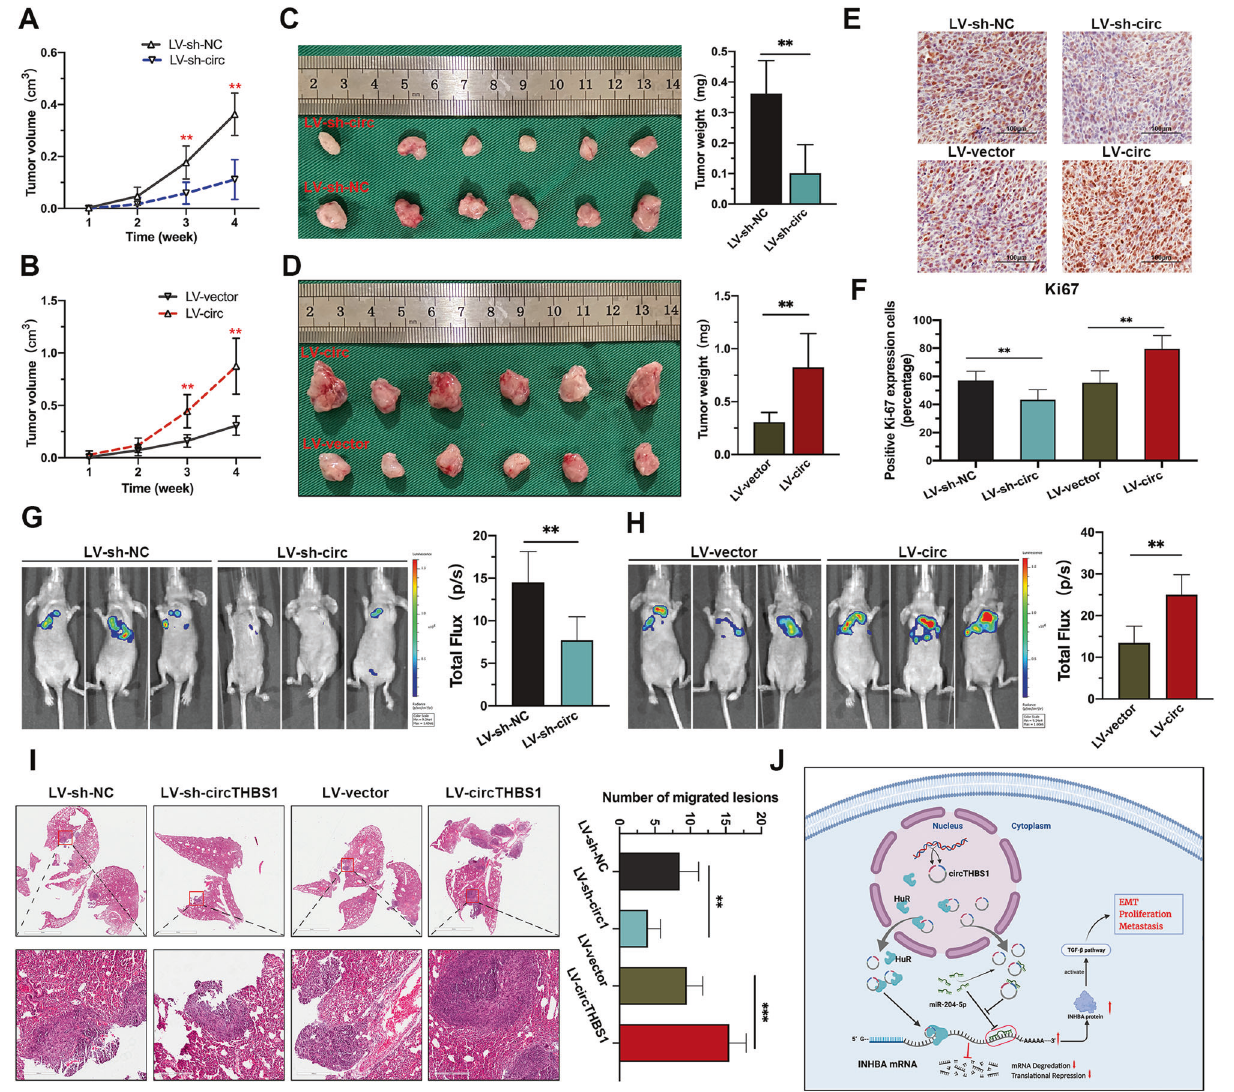
Fig. 8 CircTHBS1 promotes the growth and metastasis of GC in vivo. A, B The growth curves of subcutaneous tumors in mice ( n = 6), and the volume measured once a week. LV-sh-circ and LV-circ represent HGC-27 cells with stable knockdown and overexpression of circTHBS1, respectively. C, D Mice were sacri fi ced 4 weeks after subcutaneously injection with HGC-27 cells transfected with circTHBS1 overexpressed or knockdown lentivirus, and the volumes (left) and weights (right) of xenograft tumors were measured. E, F Immunohistochemical staining of Ki67 in xenograft tumors. G, H IVIS of mice 4 weeks after tail intravenous injection with HGC-27 cells. The luciferase intensities from the thoracic cavity were detected. I The metastatic nodules in the lungs of four groups of nude mice were stained with H&E. J The schematic diagram illustrating the mechanism of oncogenic function of circTHBS1. Quantitative data presented as the mean ± SD. * P < 0.05, ** P < 0.01, *** P < 0.001 (Student ’ s t